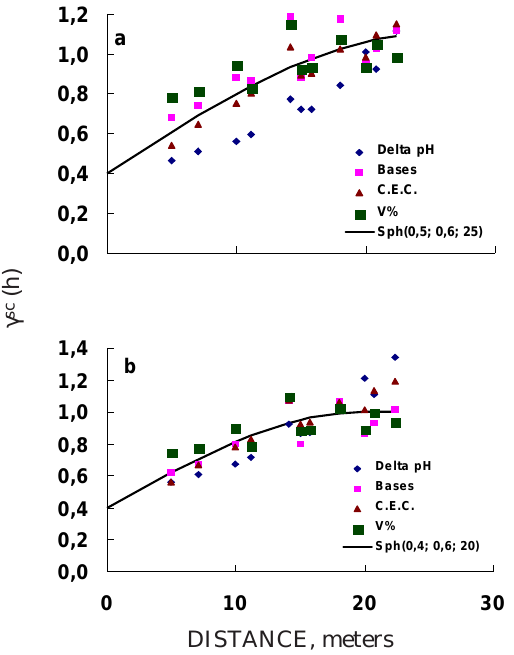
Figure 3. Scaled semivariograms for the chemical properties at 0-0,25 m in Oxisol, Campinas SP, Brazil. a) Scaling factor equals the sill of individual semivariograms. b) Scaling factor equals the calculated variance of each property.